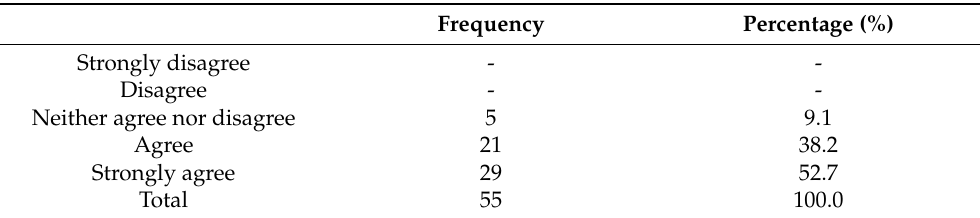
Table 1. Frequency and percentage units regarding stakeholders’ agreement with the establishment of a Hub ( N = 55).